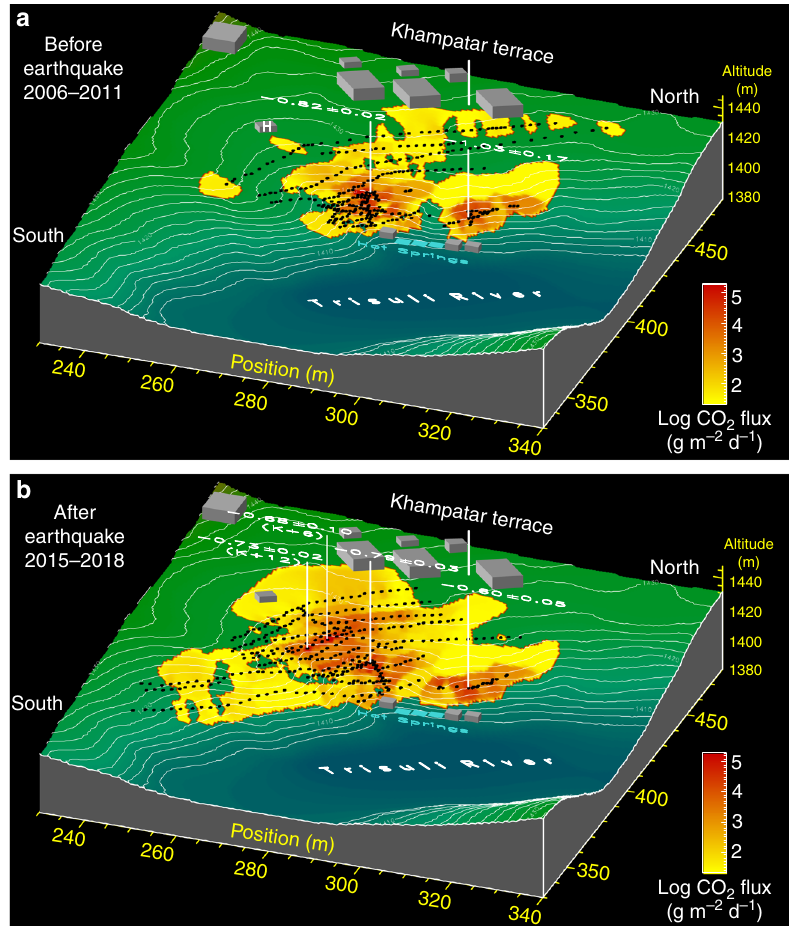
Fig. 2 Outburst of carbon dioxide emissions following the 2015 Gorkha earthquake in Syabru-Bensi, Upper Trisuli valley. Interpolated maps of surface CO 2 fl uxes above the main hot springs are shown: a before the Gorkha earthquake (652 measurements 33,34 from 2006 to 2011); b after the earthquake (577 measurements from November 2015 to January 2018). CO 2 fl uxes are expressed in logarithmic scale. Topography was determined in 2007 by geodetic levelling 62 . Numbers are carbon isotopic ratios of the gaseous CO 2 ( δ 13 C, relative to V-PDB). Total CO 2 discharge amounts to 480 ± 50 mmols − 1 (1.8 ± 0.2 ton d − 1 ) before the earthquake and 1010 ± 110 mmol s − 1 (3.8 ± 0.4 ton d − 1 ) after, giving a post-seismic overall increase of a factor of 2.1 ± 0.3. The